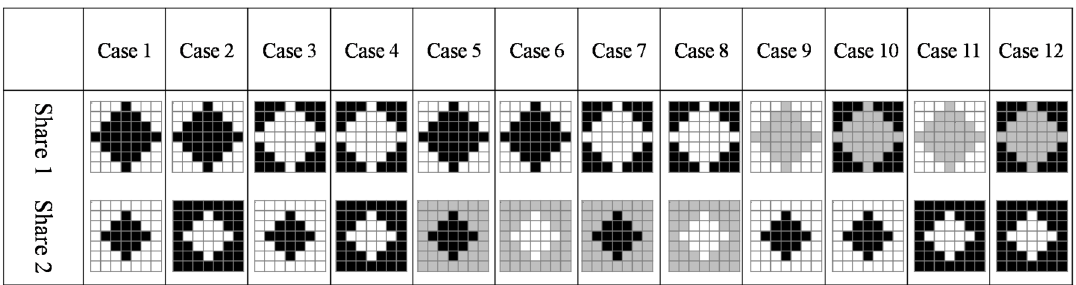
Figure 2. The patterns in Nakajima and Yamaguchi’s scheme [14].